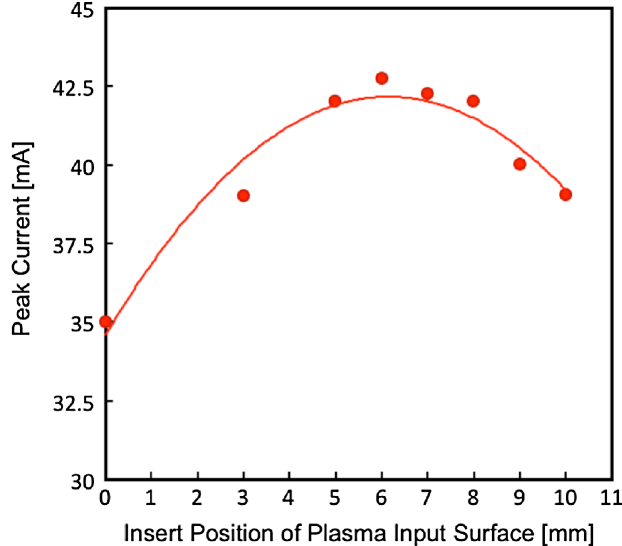
FIG. 30. Beam current waveform with self-bias (ion extraction voltage: 30 kV; pickup voltage: 5.2 V; plasma injection point: 6 mm).